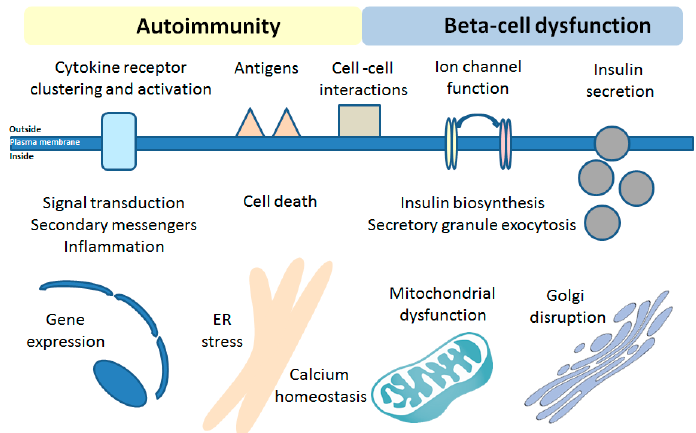
Figure 3. The possible involvement of sphingolipids in beta-cell biology during T1DM development. Rearrangements of SLs in response to the action of proinflammatory cytokines that are released by activated immune cells likely participate in islet autoimmunity, beta-cell dysfunction and death by multiple mechanisms.